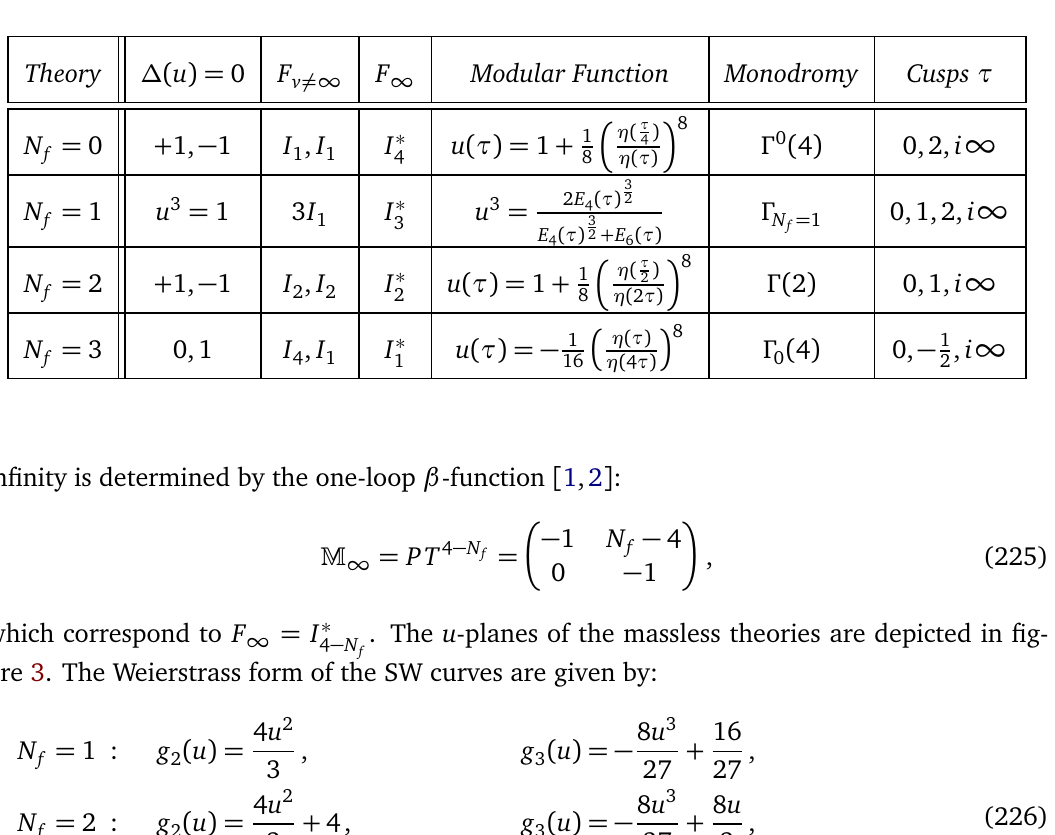
Table 9: Properties of the 4d SU ( 2 ) theory with N = 0, 2 and 3 are in the same PSL ( 2, (cid:82) ) conjugacy modular groups for N f